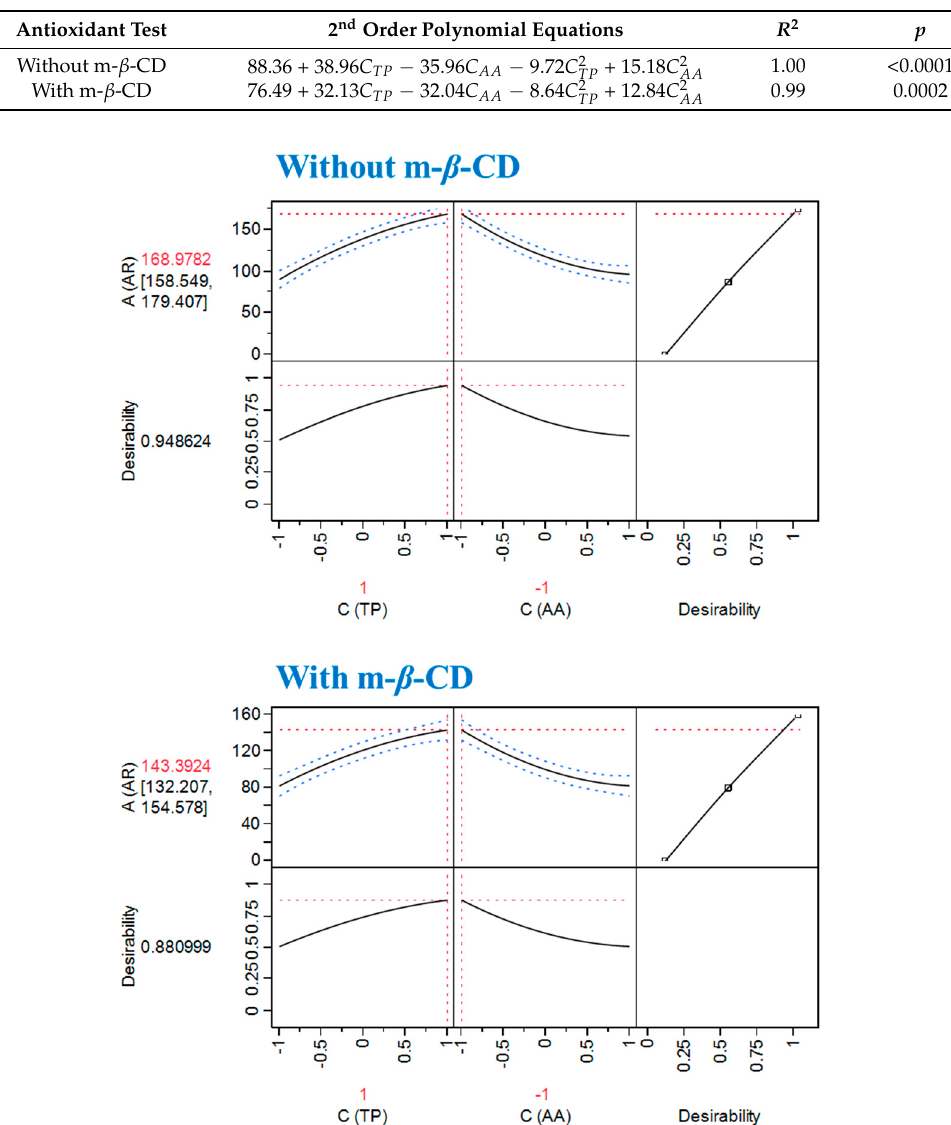
Figure 3. Prediction profiler displaying the overall desirability of the model developed, after implementing response surface methodology.